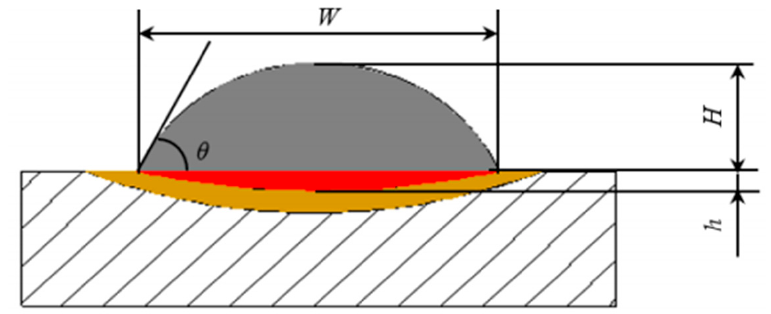
Figure 2. Schematic diagram of laser cladding single-pass geometry.